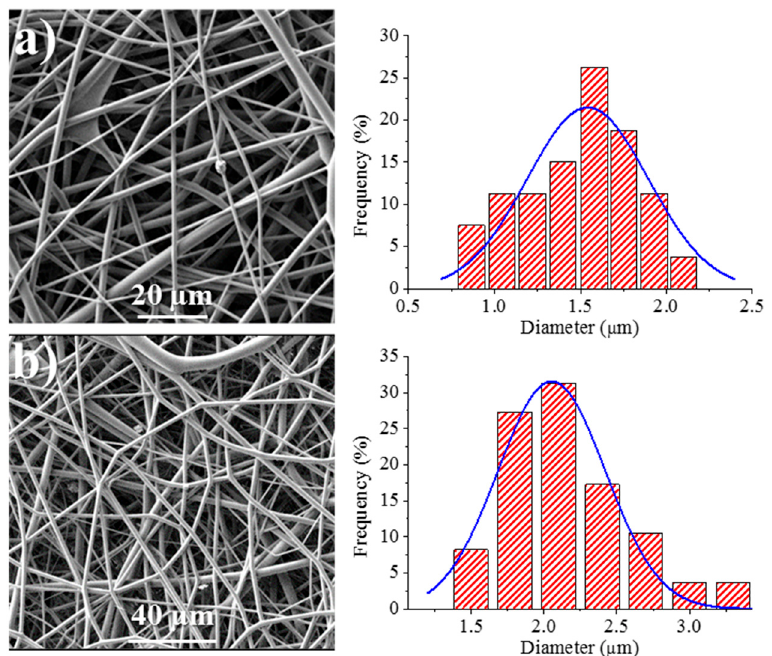
Figure 8. SEM micrographs showing electrospun 1L6 scaffolds loaded with: ( a ) Phagestaph and ( b ) Fersis freeze-dried preparations. Diameter distributions are shown on the right of the corresponding